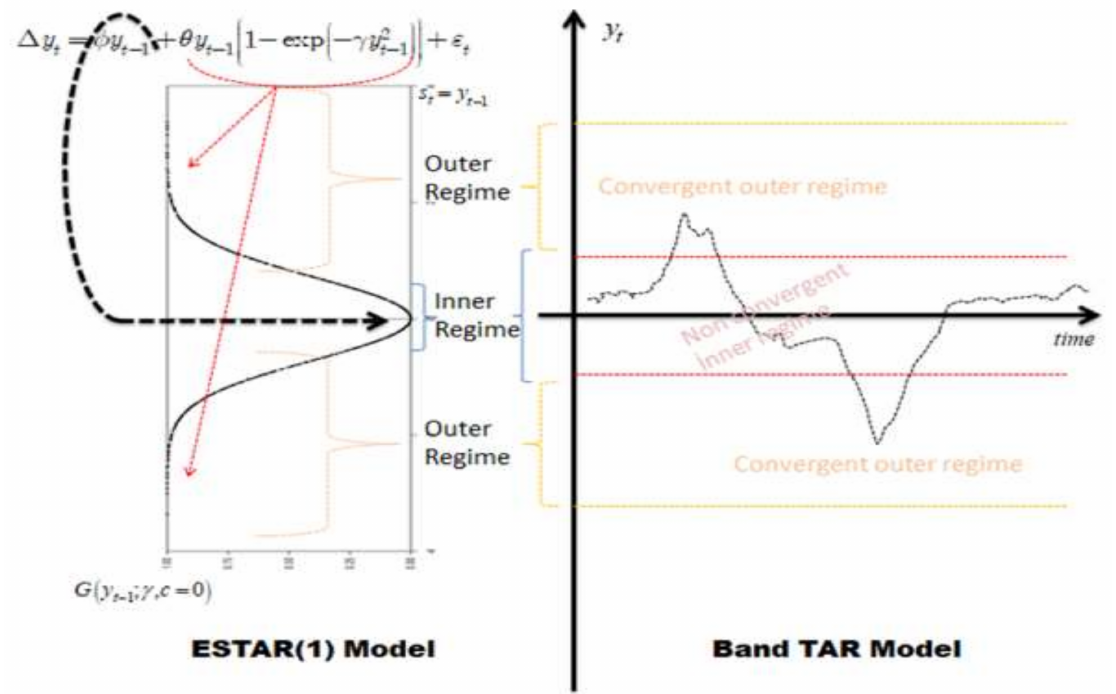
Figure 1. Explanation of the ESTAR (1) process using the band Threshold Autoregressive (TAR)